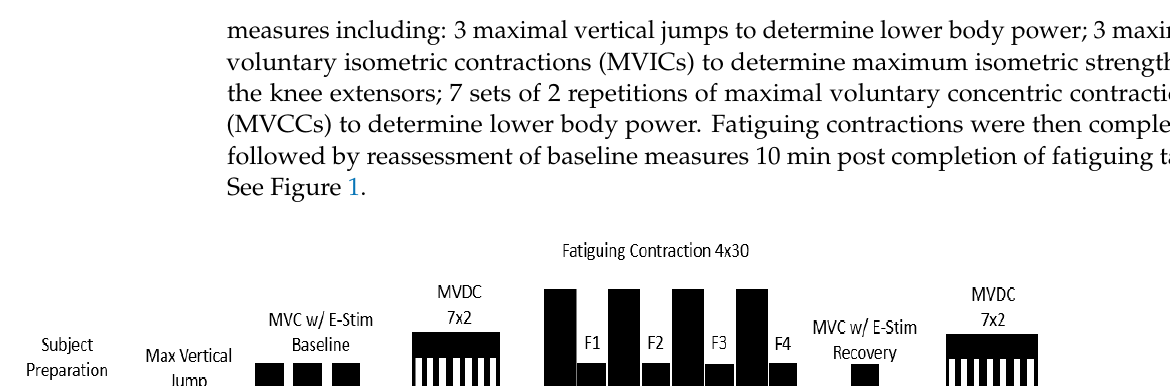
Table 1. Subject